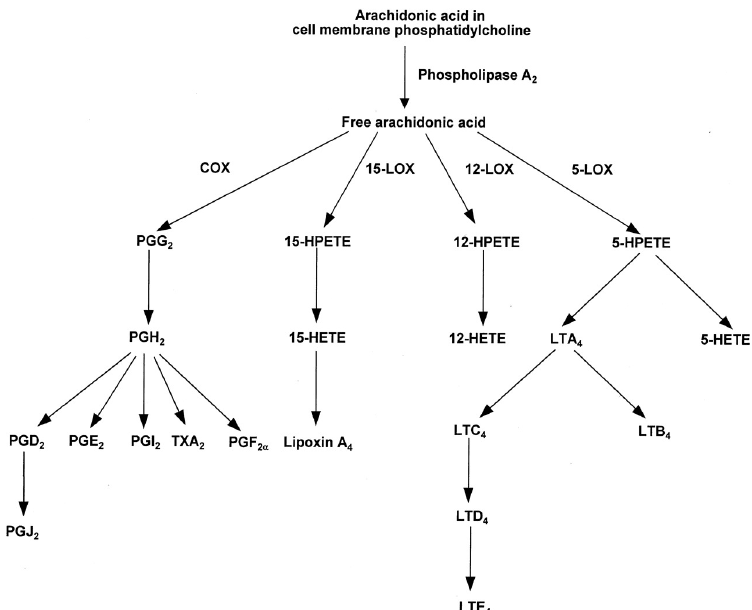
Figure 4. Generalized pathway for the conversion of ARA to eicosanoids. COX, cyclooxygenase; HETE, hydroxyeicosatetraenoic acid; HPETE, hydroperoxyeicosatetraenoic acid; LOX, lipoxygenase; LT, leukotriene; PG, prostaglandin; TX, thromboxane (from Calder